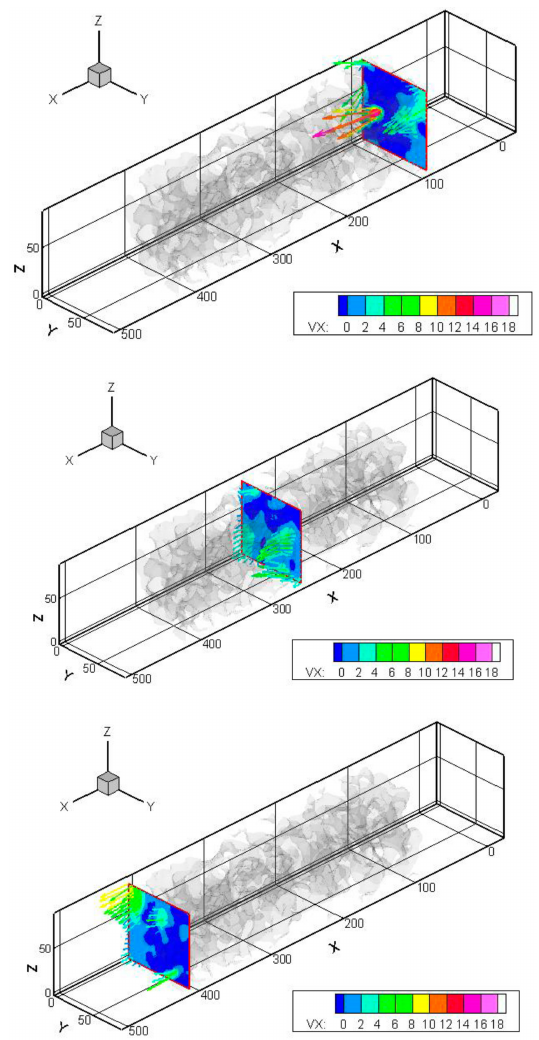
Figure 3. Distribution of velocity in X-direction at X = 92 µ m ( upper ), X = 255 µ m ( middle ), X = 411 µ m ( lower ) of sample